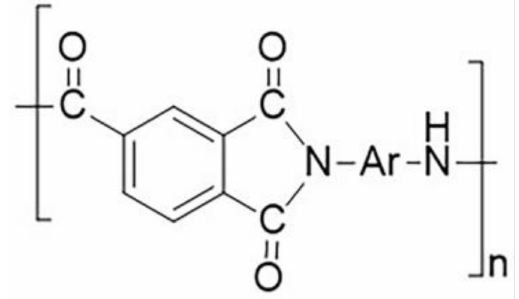
Scheme 1. PAI molecular structural